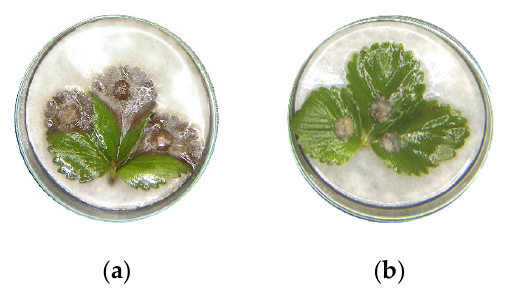
Figure 3. Infection of grey mould on detached strawberry leaves 7 days after inoculation, after treatment with ( a ) cinnamon ( C. cassia ) extract; ( b ) clove ( S. aromaticum ) extract.